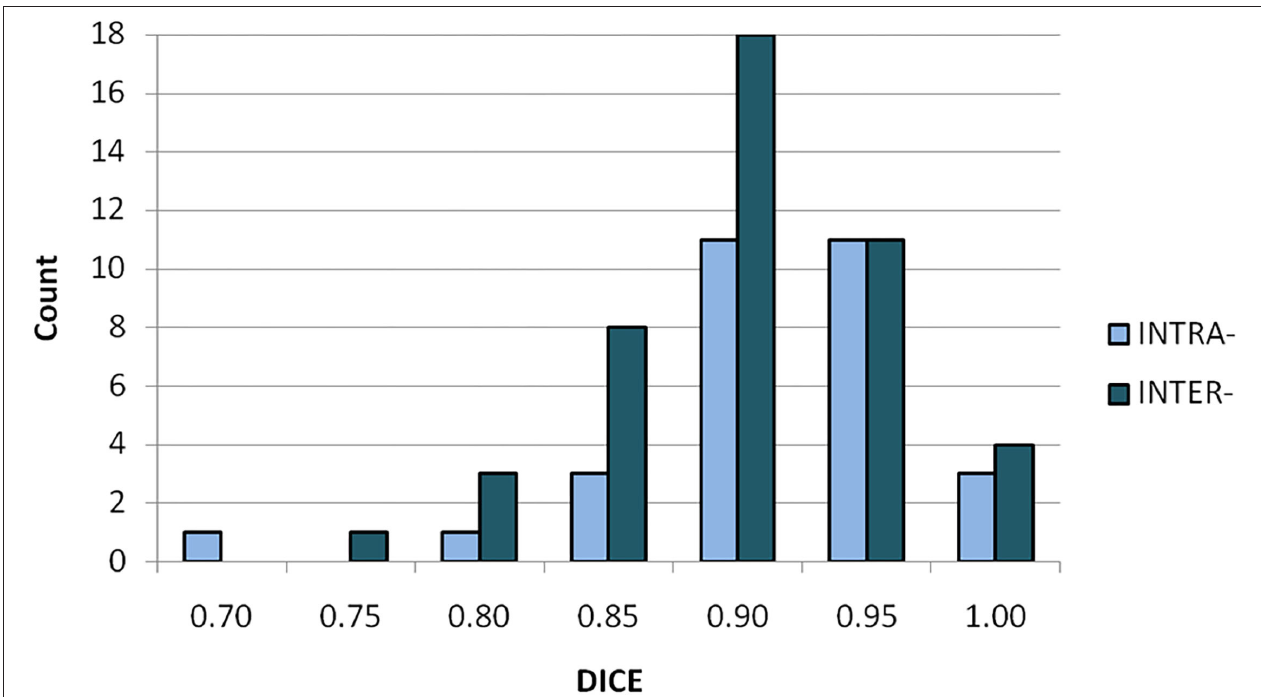
FIGURE 3 | Differential histogram of DICE coefficients for intra- (light/blue) and inter-observer (dark/aquamarine) variabilities.